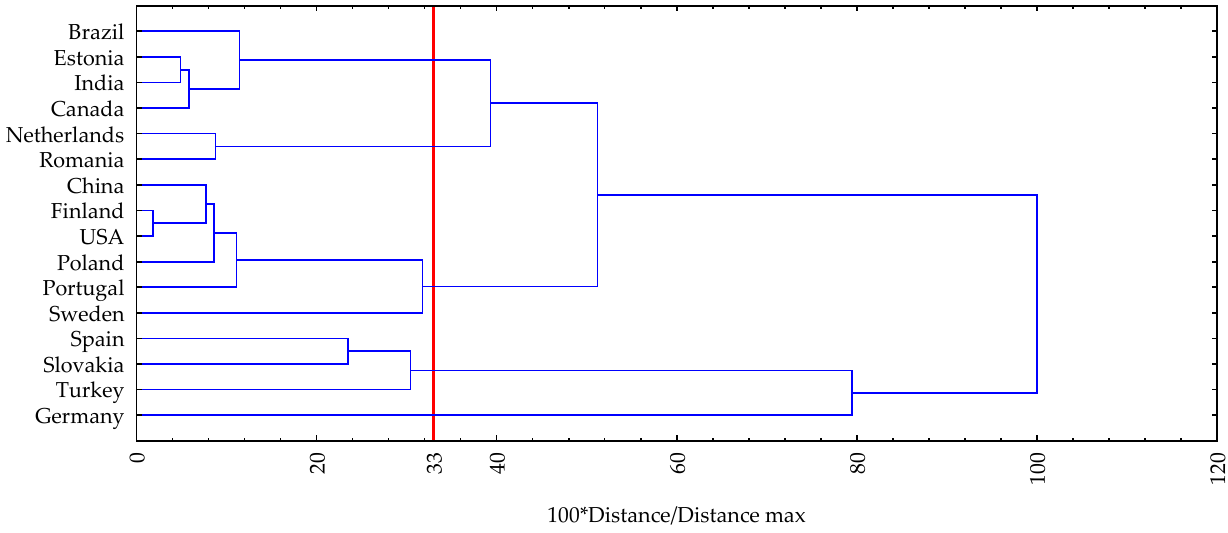
Figure 13. Cluster analysis for energy potential characteristic of dendromass in selected countries.